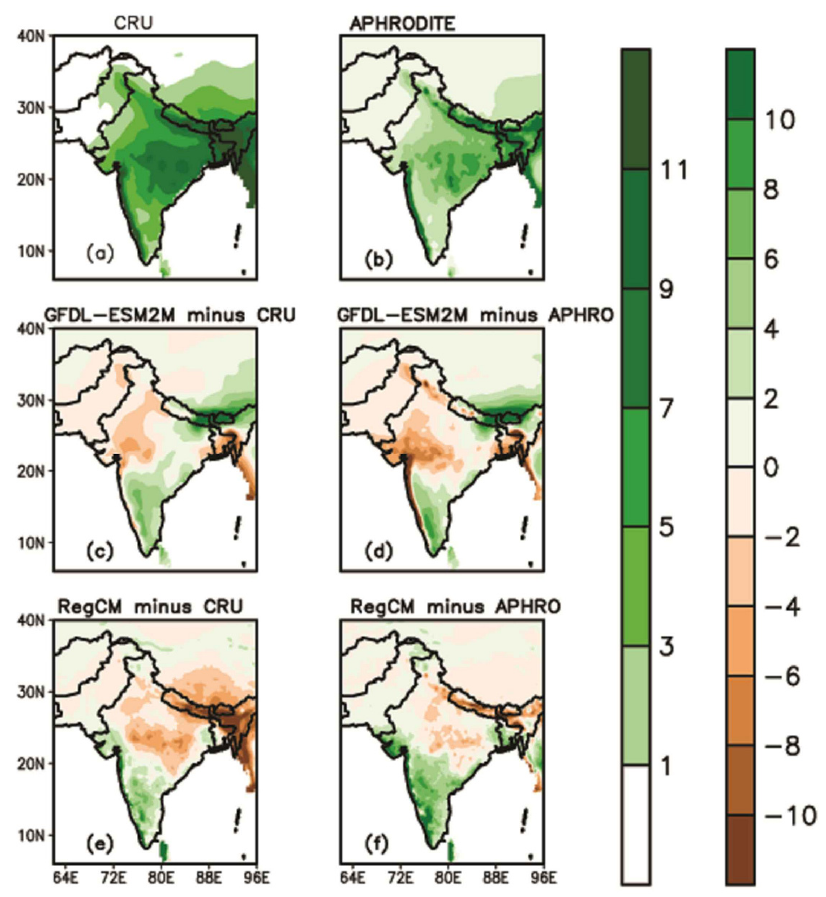
Figure 3. Spatial distribution of SASM mean precipitation (mm/day) for ( a , b ) CRU and APHRODITE observations, ( c , d ) GFDL − ESM2M and ( e , f ) RegCM4 model biases with respect to